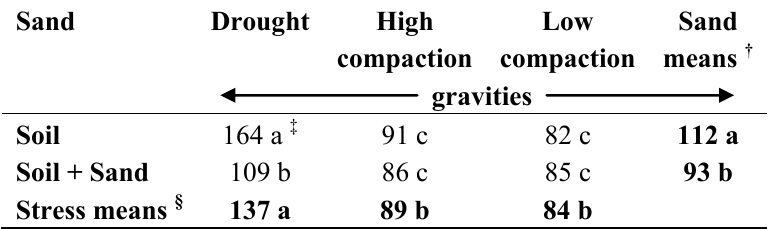
Table 7. The influence of sand layering and applied stress on surface hardness (SH). Sand